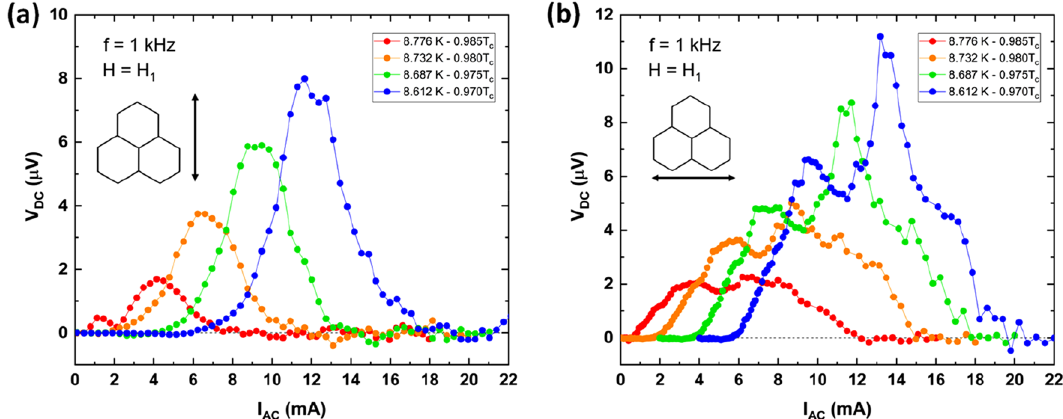
Figure 2. Temperature dependence of ratchet effect in as-grown (sample A) Nb film on top of honeycomb spin ice of Co connected nanomagnets (Temperatures are shown in the inset). Y-axis output dc voltages. X-axis input ac current (1 kHz). The applied magnetic field perpendicular to the sample plane is H 1 = 40 Oe (filling factor: one vortex per array unit cell) and critical temperature T c0 = 8.91 K. ( a ) Vortex motion parallel to easy-axis (inset shows the honeycomb array and direction of the vortex motion). ( b ) Vortex motion parallel to hard-axis (inset shows the honeycomb array and direction of the vortex motion).